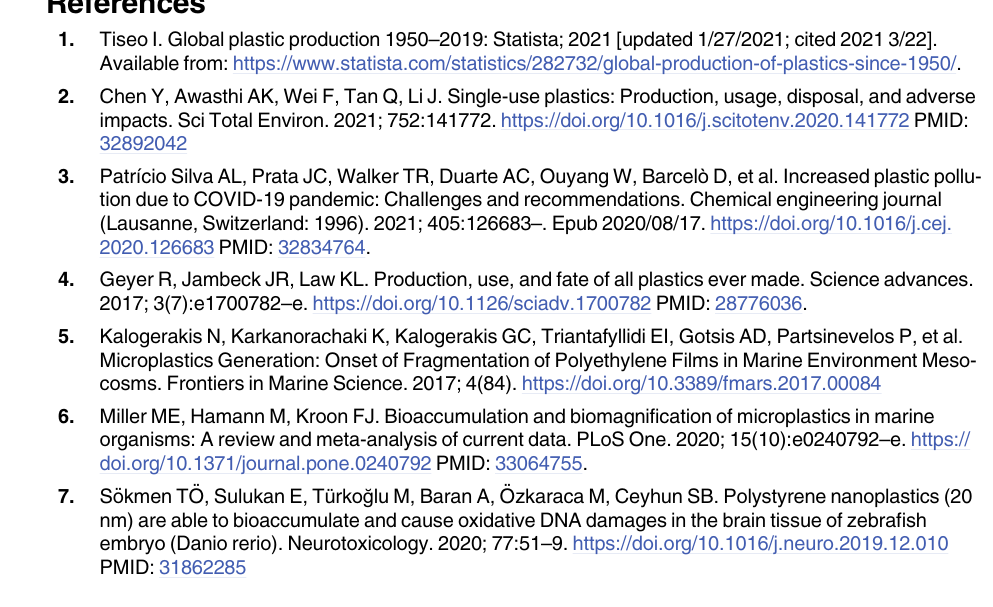
S7 Table. ANOVA table for Annexin V-PI apoptosis assay study (24 h). (PDF) S8 Table. ANOVA table comparing Annexin V-PI apoptosis at 4 and 24